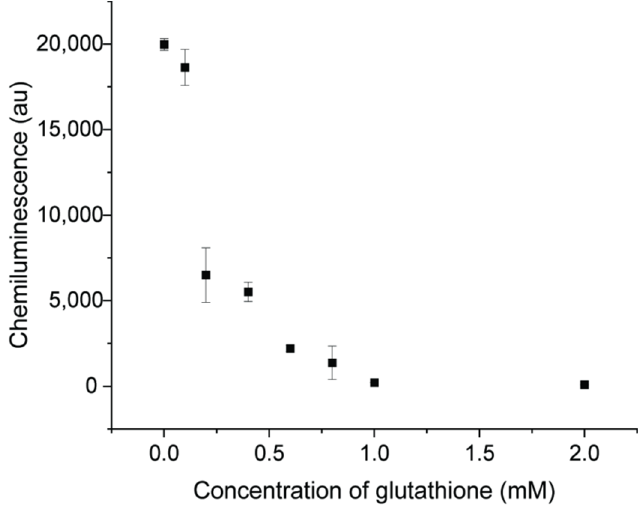
Figure 9. CL signals of luminol–NaOCl mixed with AuNPs and different concentration of glutathione (0.01, 0.1, 0.2, 0.4, 0.6, 0.8, 1.0, 2.0 mM).